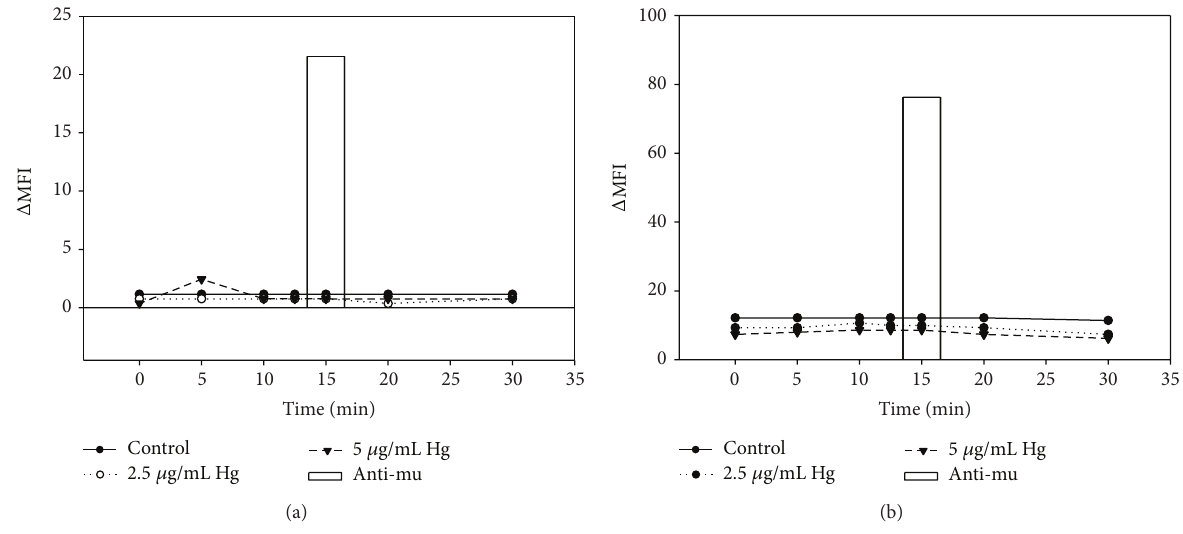
Figure 3: Effect of Hg +2 and anti-mu (12.5 𝜇 g/mL) as a function of time after addition of (a) pERK and (b) pSyk.